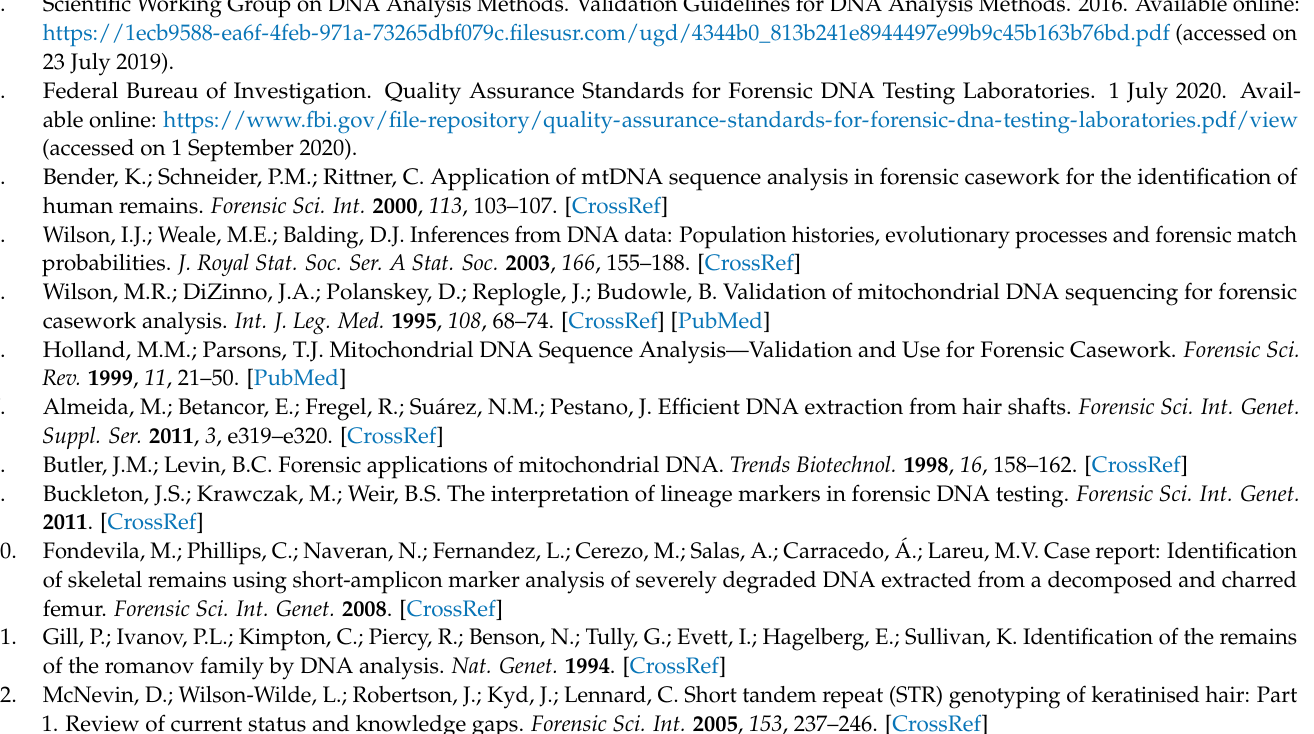
Table S5: mtGenome variants detected in five well characterized DNA samples from the project report generated in the ForenSeq universal analysis software, Table S6: mtGenome variants detected in 1000 genomes DNA samples from the project report generated in the ForenSeq universal analysis software, Table S7: Approximate amplicon coverage for samples in the species-specificity study with the mtGenome